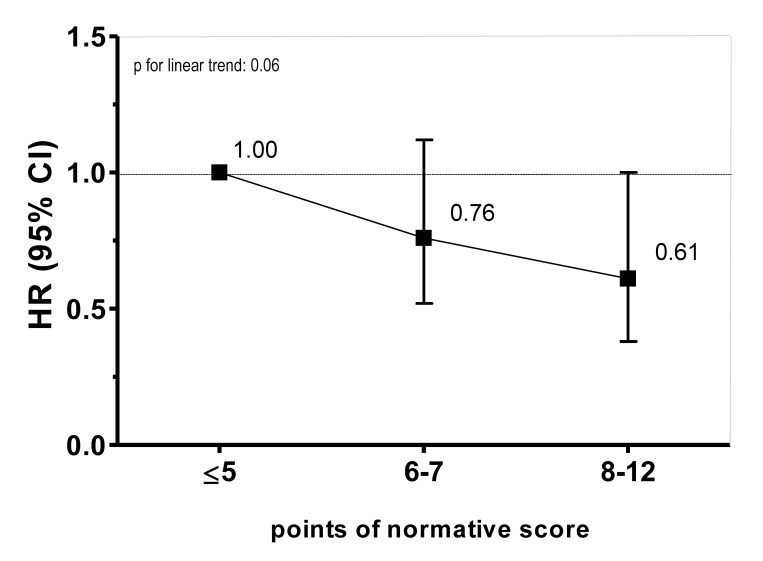
Hazard ratios (HR) and 95% confidence interval (CI) for incident T2DM according to a DDS.For this analysis we used servings/day or servings/week (i.e. normative or absolute cut-off points [31,32]), assigning one point to each of the 12 goals accomplished. Results represent a fully adjusted model, adjusted for age (as the underlying time variable), sex, total energy intake, following a special diet, snacking between meals, BMI, physical activity, hours of television watching, hours sitting down, smoking, marital status, personal history of hypertension, and family history of diabetes [parents and/or siblings]).